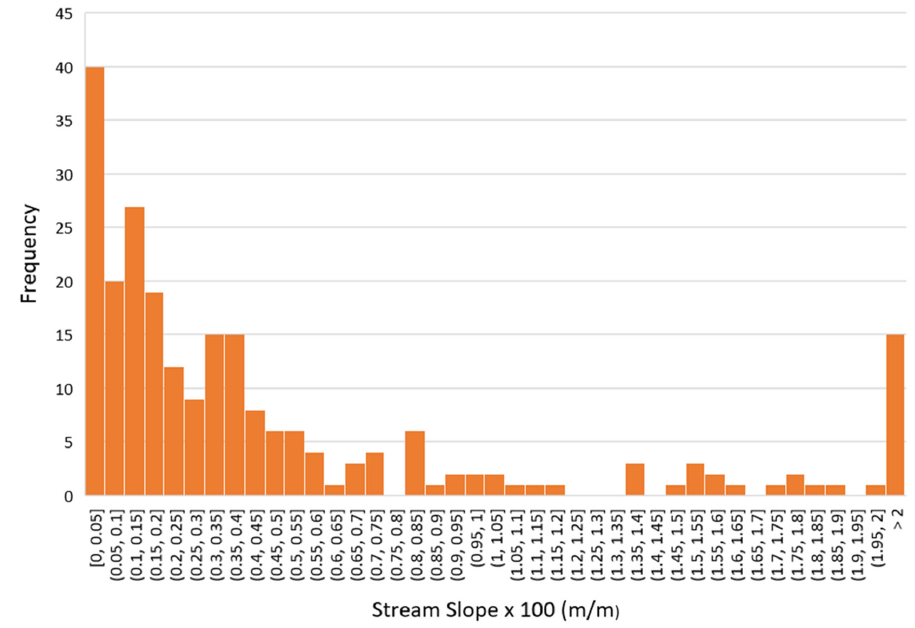
Figure 11. Stream slope at low head dams in Pennsylvania with no fatalities recorded.